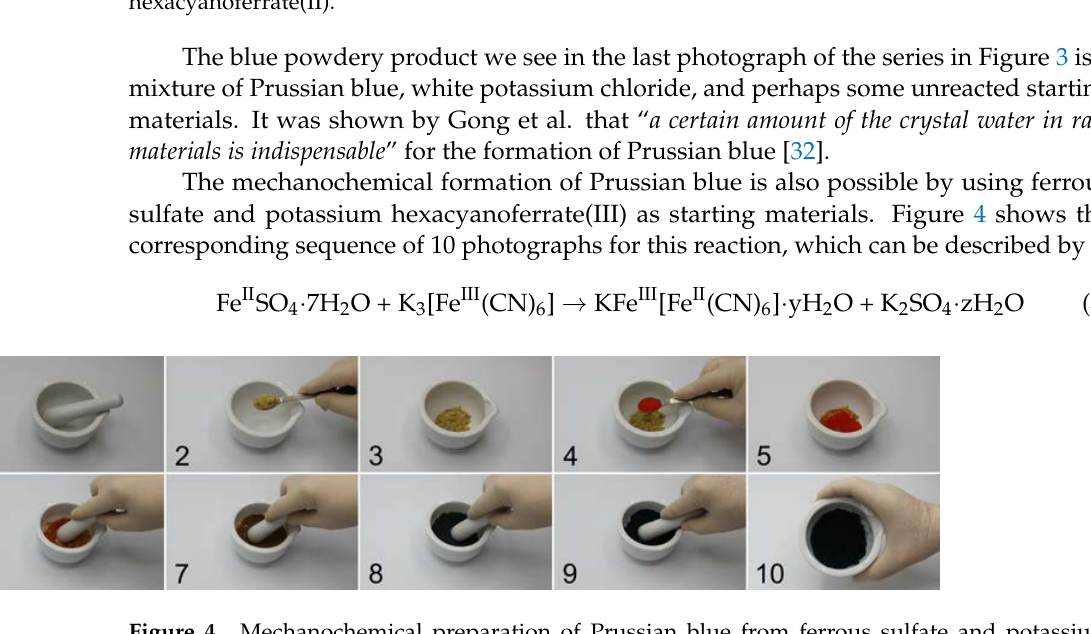
Figure 3. Mechanochemical preparation of Prussian blue from ferric chloride and potassium hexacyanoferrate(II).